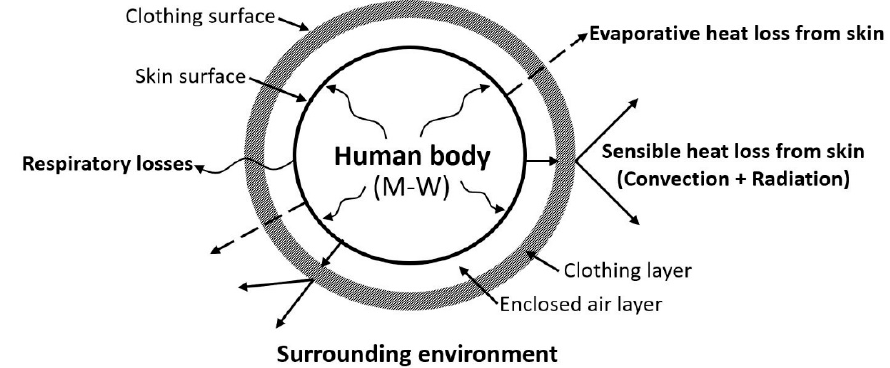
Figure 1. Heat balance between the human body and the surrounding environment, where M is the metabolic rate and W is the external work [19].